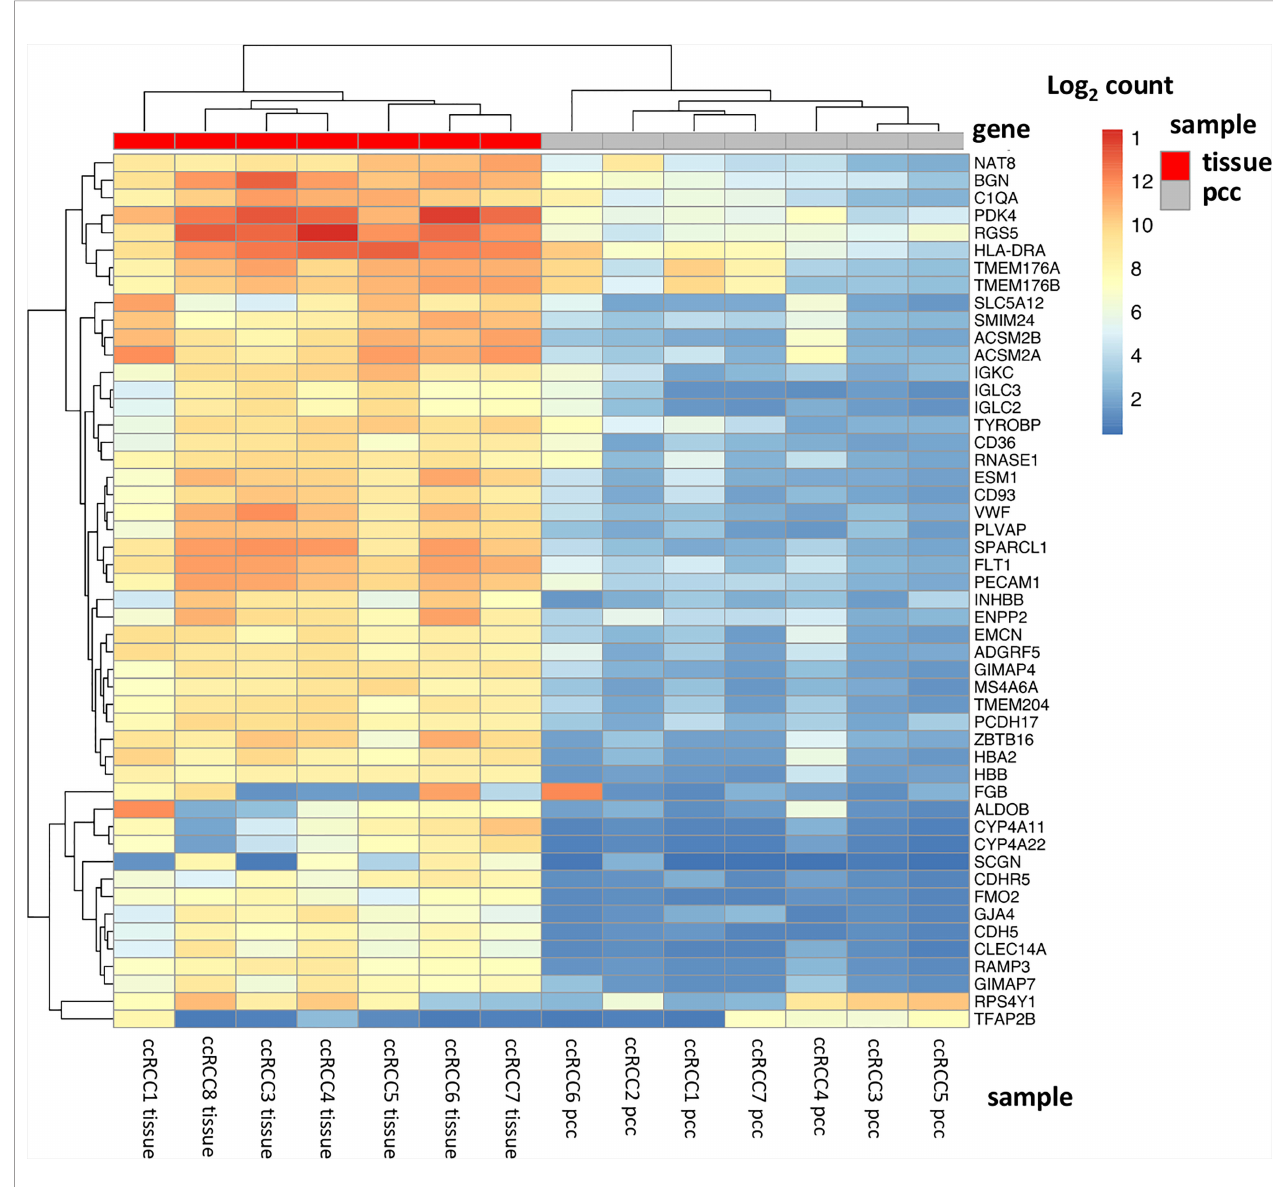
FIGURE 2 | Top50 dysregulated genes inccRCC tissue andprimary cellcultures. The heatmapdisplaysthe top50 signi fi cantly dysregulated genes inseven ccRCC tissue specimens as well as in7 ccRCC primarycell cultures. Amongthese genes, there are genes involved inhypoxia signaling andmetabolic regulation ( PDK4, RGS5, ALDOB, SLC5A12, ACSM2A, ACSM2B ), incell adhesion and extracellular matrix( CDH5, PECAM1, SPARCL1 ),angiogenesis( ESM1 ) andimmune signaling ( TYROBP